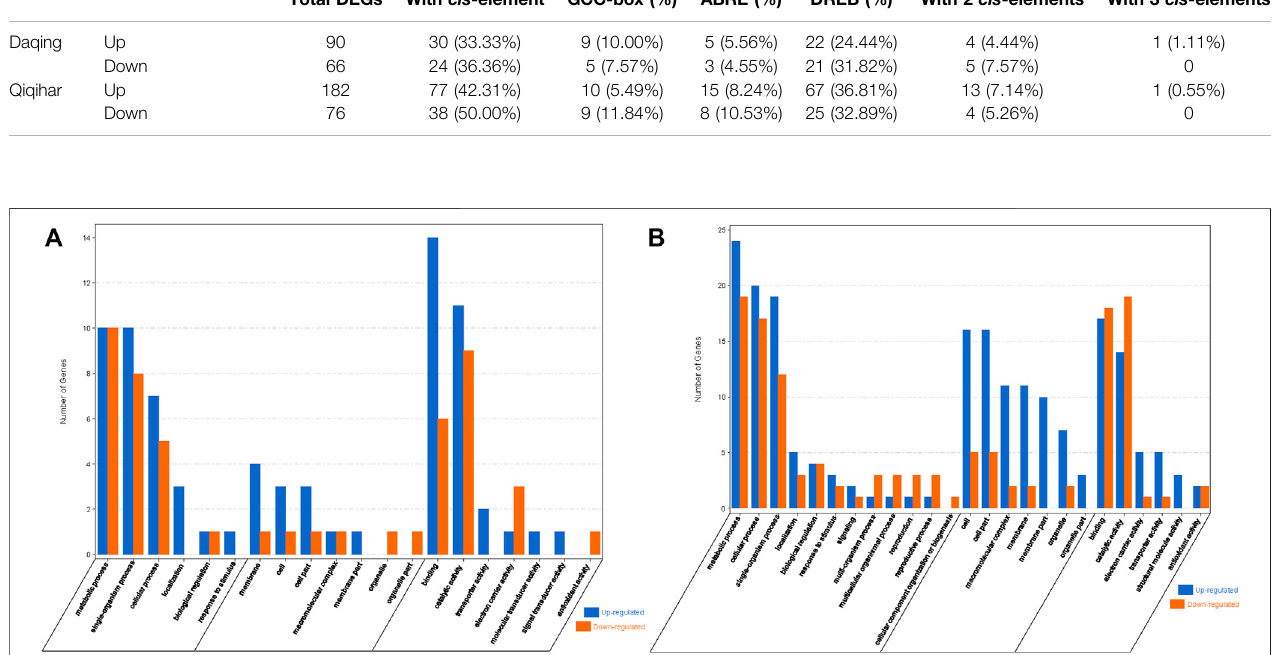
FIGURE 7 | GO enrichment analysis of DEGs with JERF-binding cis-elements in their promoter regions. (A) . ABJ01 vs. 9# in Daqing; (B) . ABJ01 vs. 9# in Qiqihar. Up, upregulated DEGs; DOWN, downregulated DEGs.